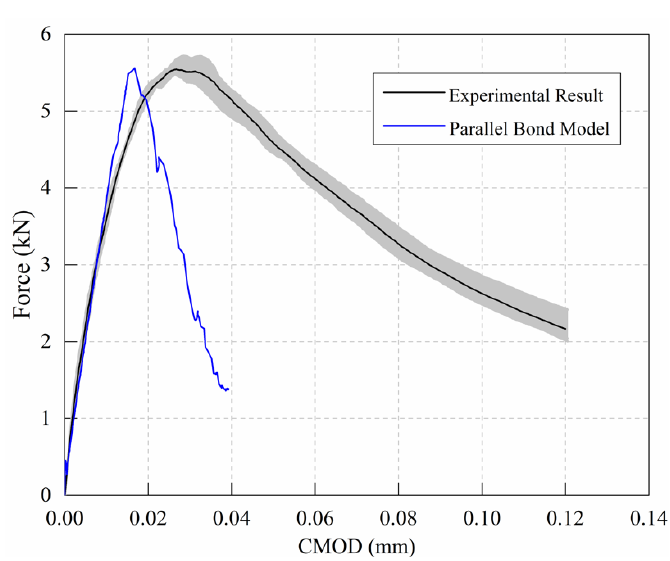
Figure 5. Comparison of parallel bond model results and test results.